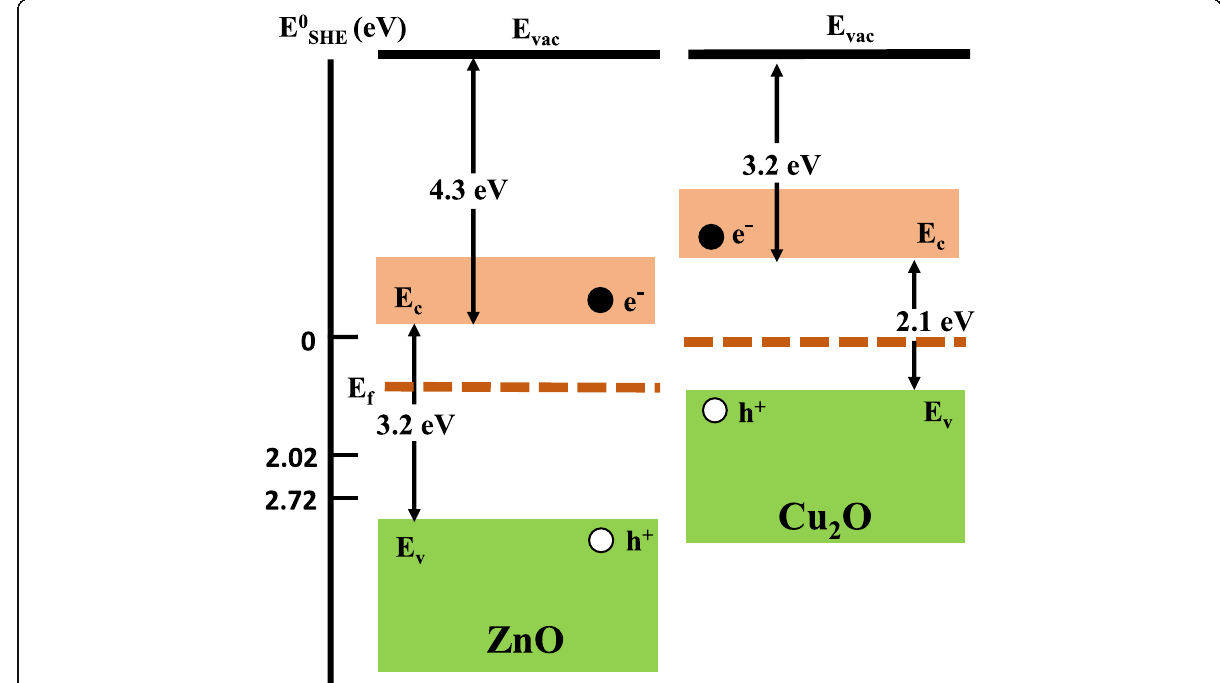
Fig. 9 The energy band diagrams of ZnO and Cu 2 O and the standard reduction potentials for Eqs. (1) and (2). The reduction potential is relative to SHE, which is 4.44 eV below the vacuum level